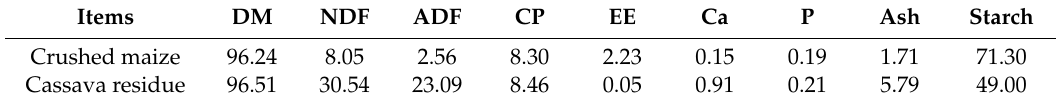
Table 1. Nutrient contents of cassava residue and crushed maize (air-dried matter basis, %). Items